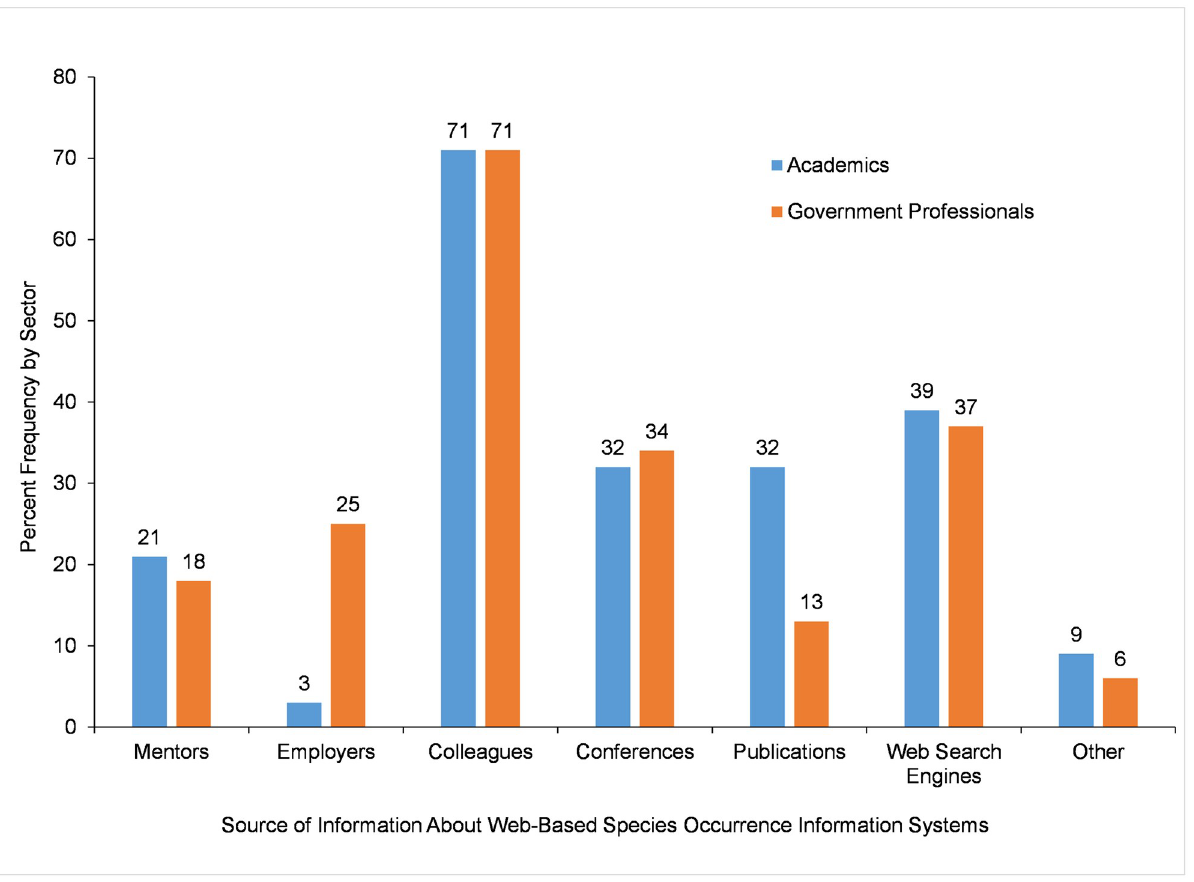
Fig 5. Source of information where participants learned about web-based species occurrence information